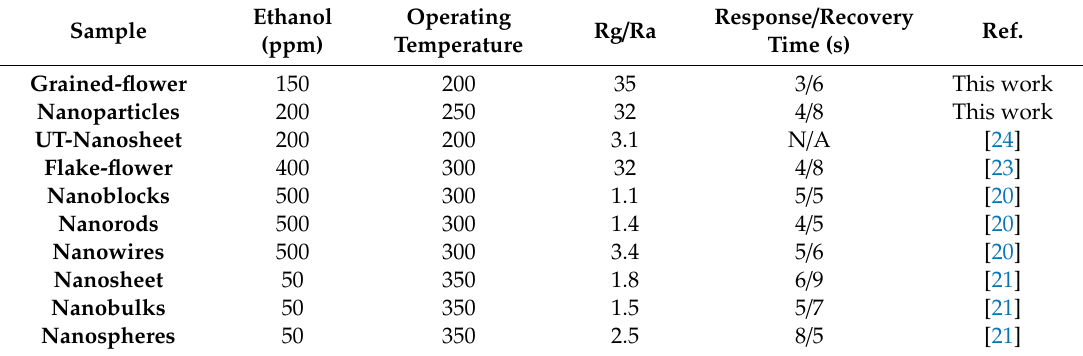
Table 2. Comparison of the performances of di ff erent NiO based ethanol sensors. UT = Ultrathin. Ethanol Sample (ppm)